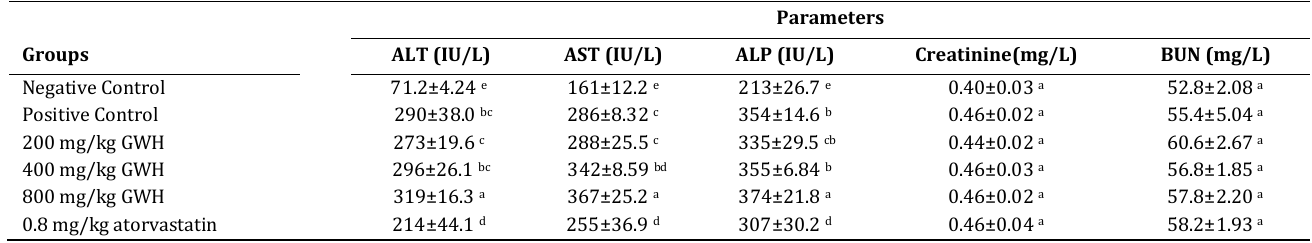
Table 4 . Effect of methanolic extract of green walnut husk (GWH) on liver and kidney functions of all groups after 42 days of the experiment 1